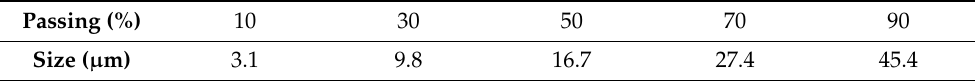
Table 1. The particle size distribution of quartz used in this study.